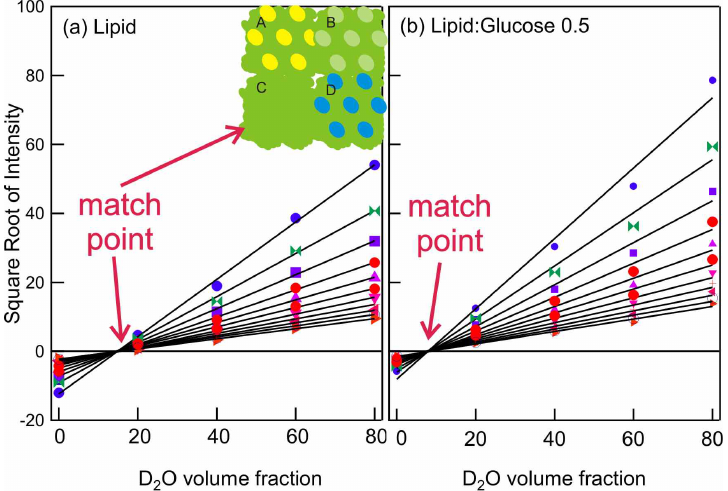
Figure 5. Square root of intensity vs. D O volume fraction for the data in Figure 4. A 2 schematic representation where the scattered intensity is proportional to the contrast between the two phases is shown in the inset. In this case, the scattering is due to the contrast, (or difference in scattering length density) 2 , between the aqueous phase O:D O:D -glucose) and the lipid (various ratios of H 2 2 6